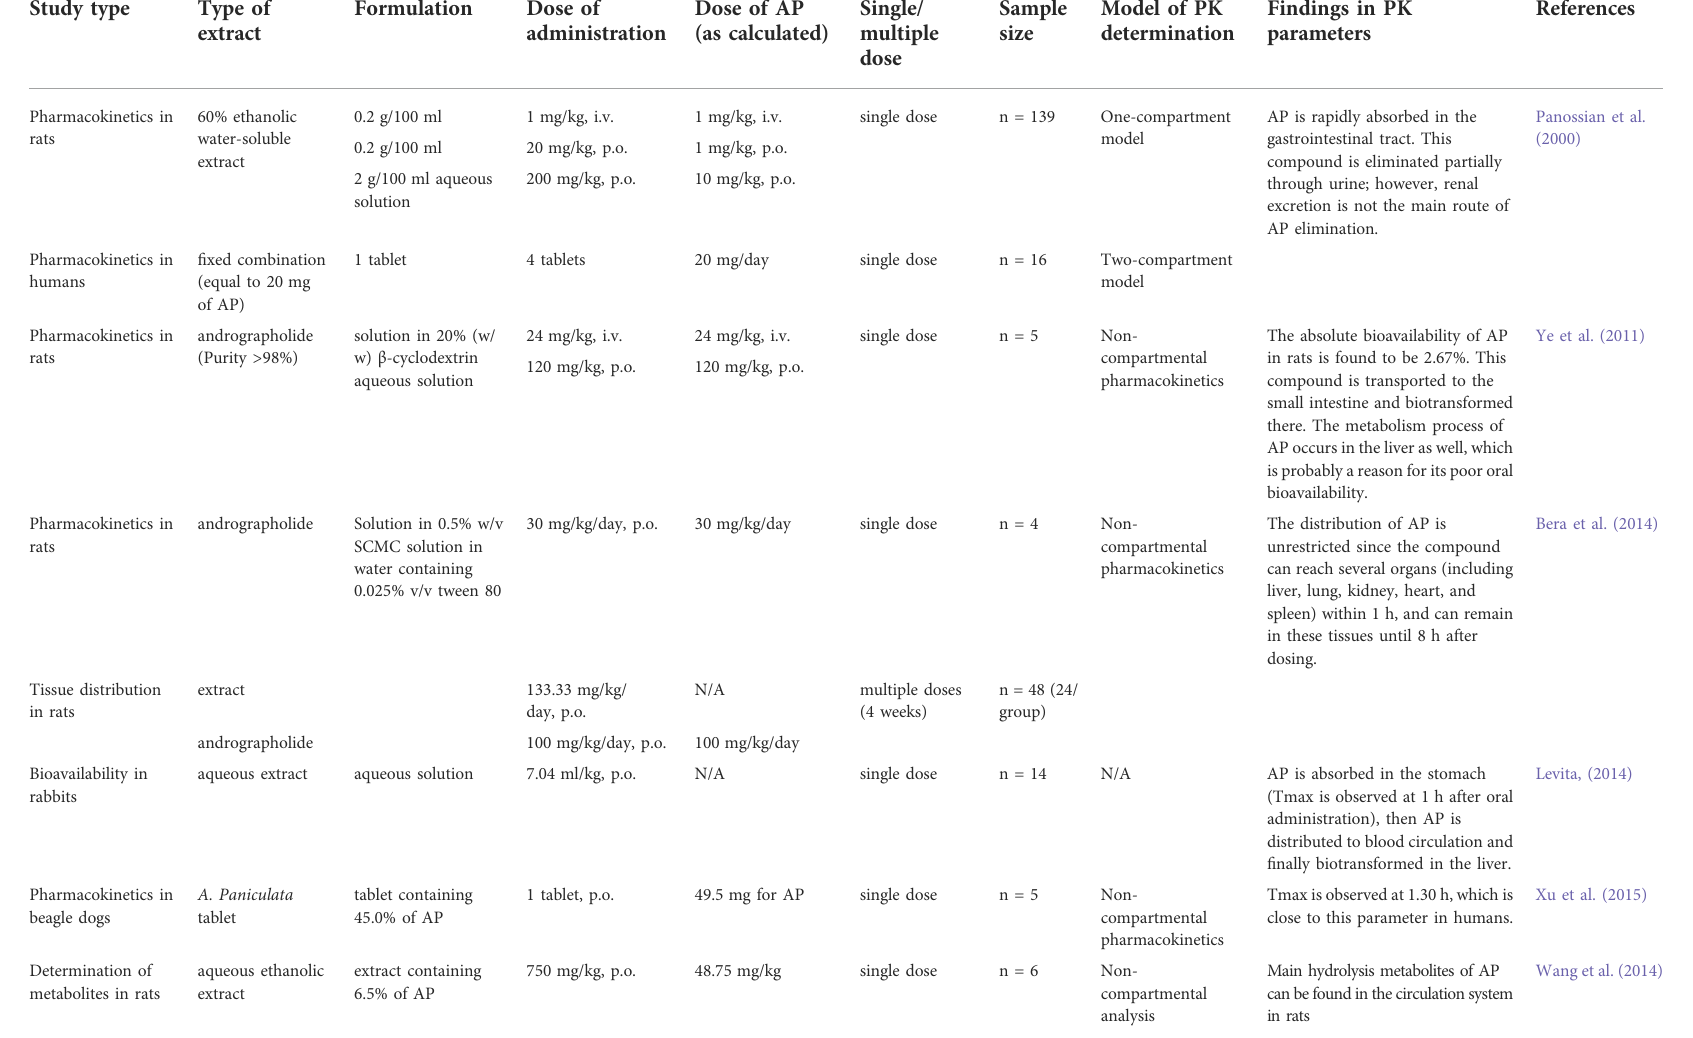
TABLE 2 Preclinical and clinical pharmacokinetic studies of A. paniculata extract and its bioactive component, andrographolide